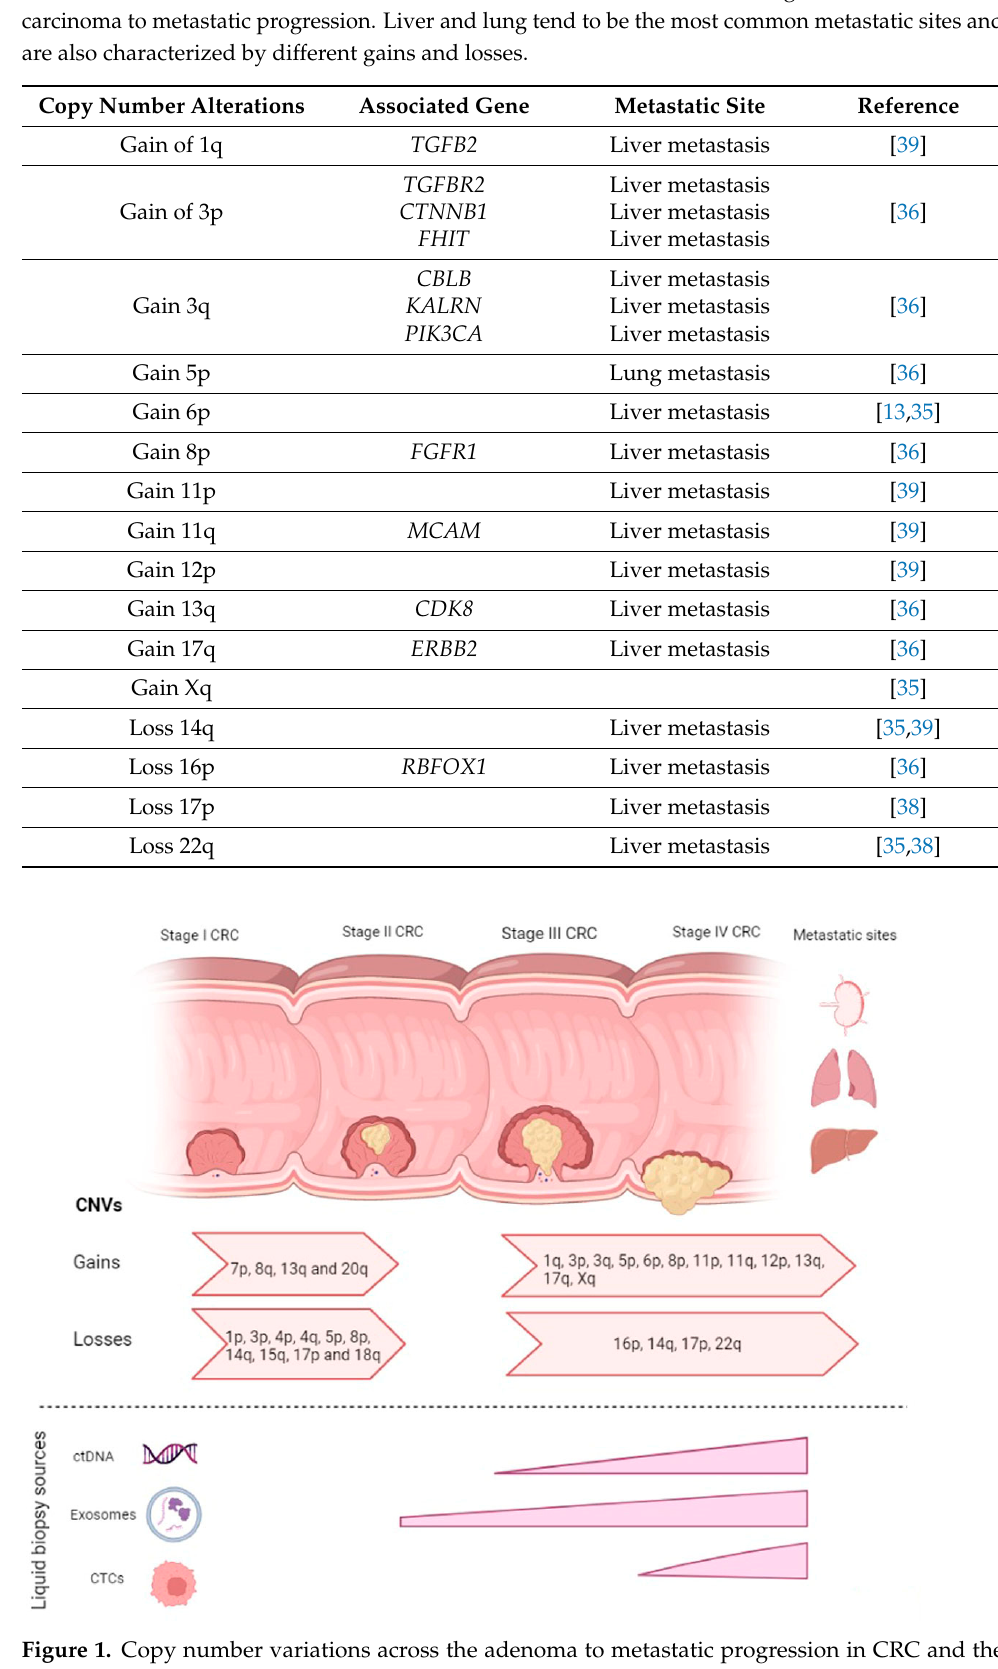
Figure 1. Copy number variations across the adenoma to metastatic progression in CRC and the occurrence (abundance) of different liquid biopsy sources along the malignant transformation. occurrence (abundance) of different liquid biopsy sources along the malignant